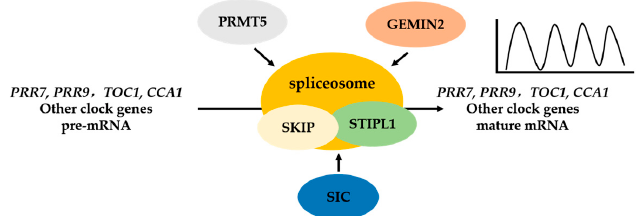
Figure 2. Components of spliceosome and splicing regulators mediate alternative splicing of the circadian clock genes in Arabidopsis . The Ski-interacting protein (SKIP), SPLICEOSOME TIMEKEEPER LOCUS 1 (STIPL1) are components of the spliceosome. Protein arginine methyltransferase 5 (PRMT5),